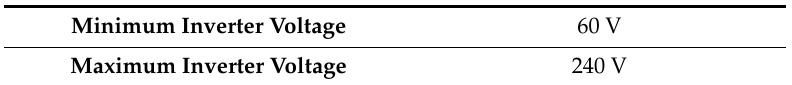
Table 2. Input inverter